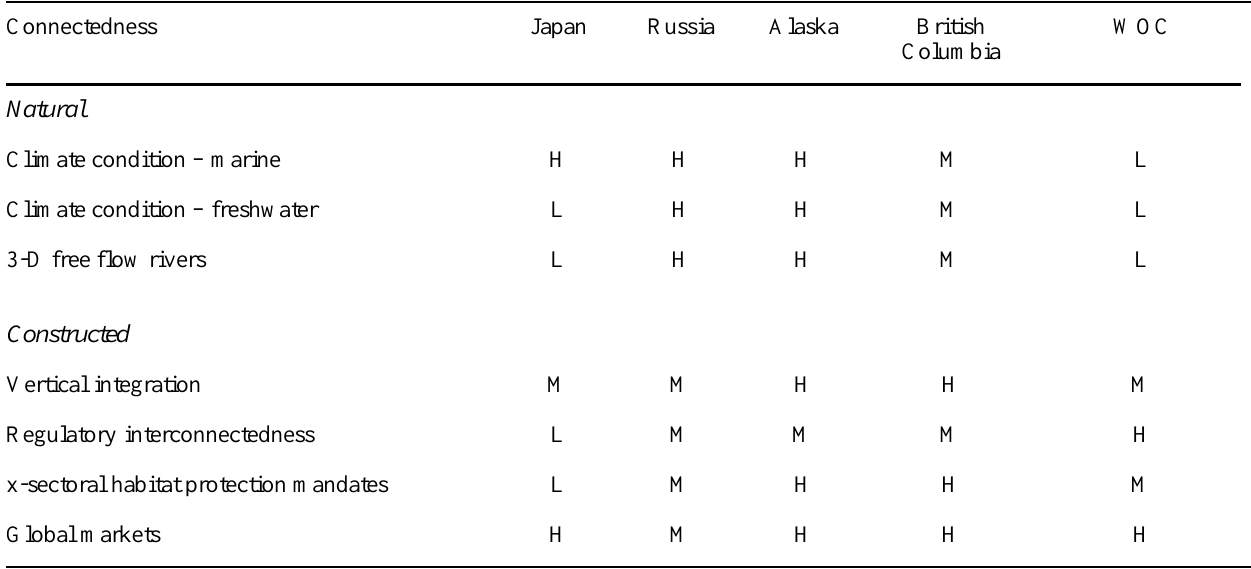
Table 3. Connectedness rankings for the five salmon fishing regions. Hi is for high rankings, M is medium, and L is